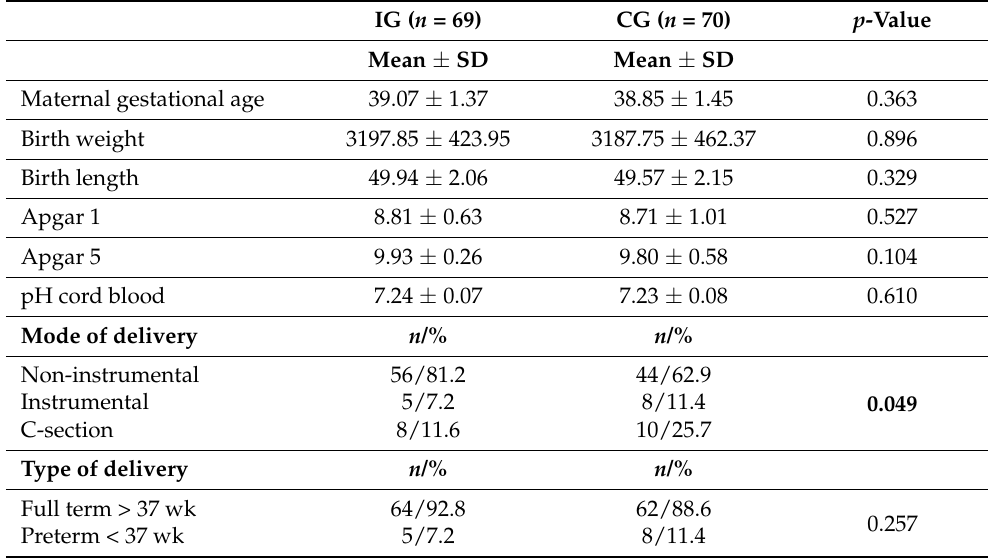
Table 5. Secondary outcomes in both study groups: IG—intervention group; CG—control group. IG ( n = 69) CG ( n = 70) p